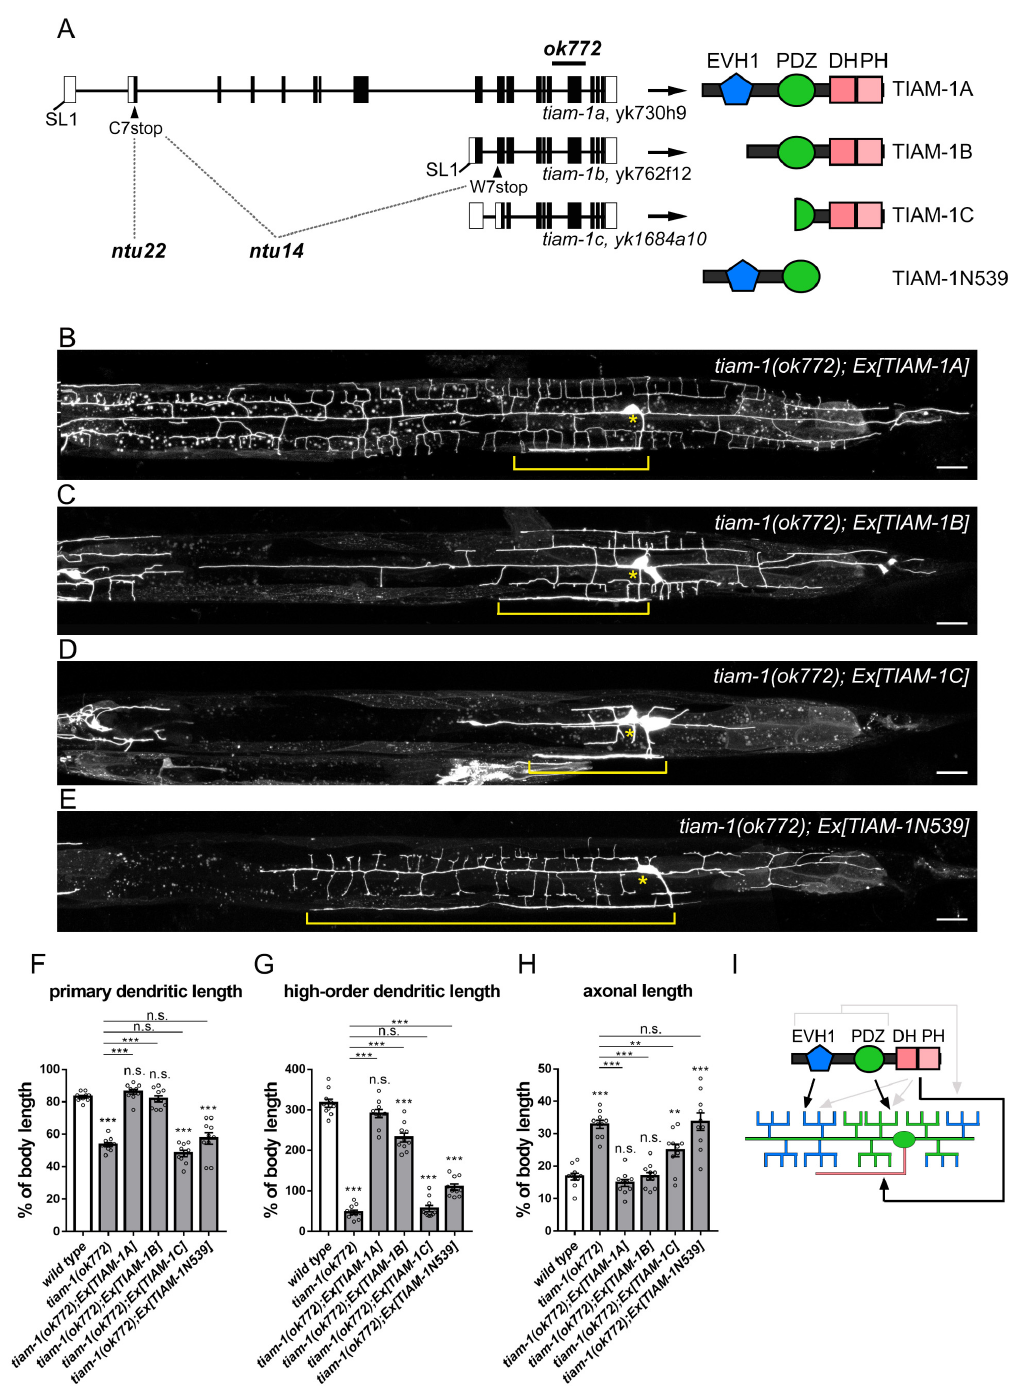
Fig 2. Different TIAM-1 protein regions regulate the development of PVD subcompartments. (A) Schematic diagram of three tiam-1 cDNAs showing exons (black boxes), introns (lines), 5’ and 3’ untranslated regions (UTRs) (white boxes), SL1 trans-spliced leader sequence, and mutation sites of three tiam-1 alleles ( ok772 and two CRISPR/Cas9 engineered alleles, ntu14 , and ntu22 ). Functional domains of TIAM-1 isoforms are illustrated. (B-E) tiam-1(ok772) mutant PVD neuron with the expression of Ex[Pdes-2 :: TIAM-1A] (B), Ex[Pdes-2 :: TIAM-1B] (C), Ex[Pdes-2 :: TIAM-1C] (D), and Ex[Pdes-2 :: TIAM-1N539] (E) transgenes. PVD morphology is labeled by myr::mCherry ( ntuIs1 ). Scale bar, 20 μ m. (F-H) Quantification of the relative primary dendritic length (F), high-order dendritic length (G), and axonal length (H) in tiam-1(ok772) mutant